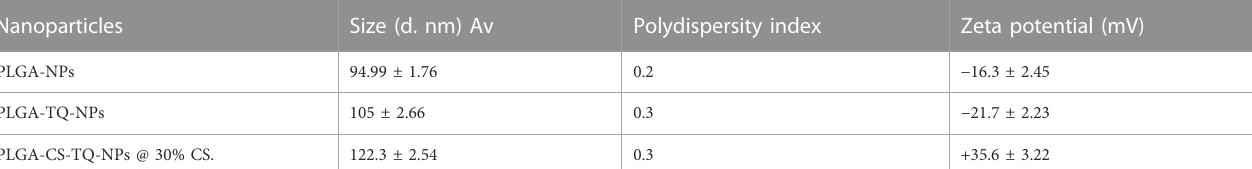
TABLE 2 Major characteristics of NPs